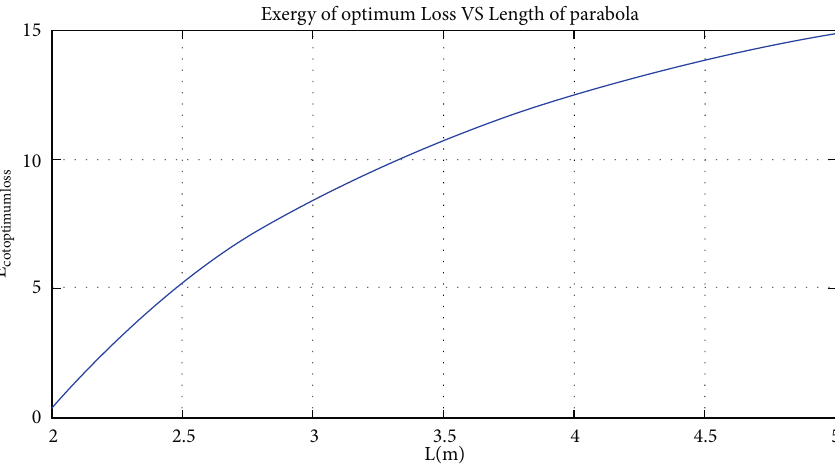
Figure 8: Changes of optimal loss of exergy by length of absorber